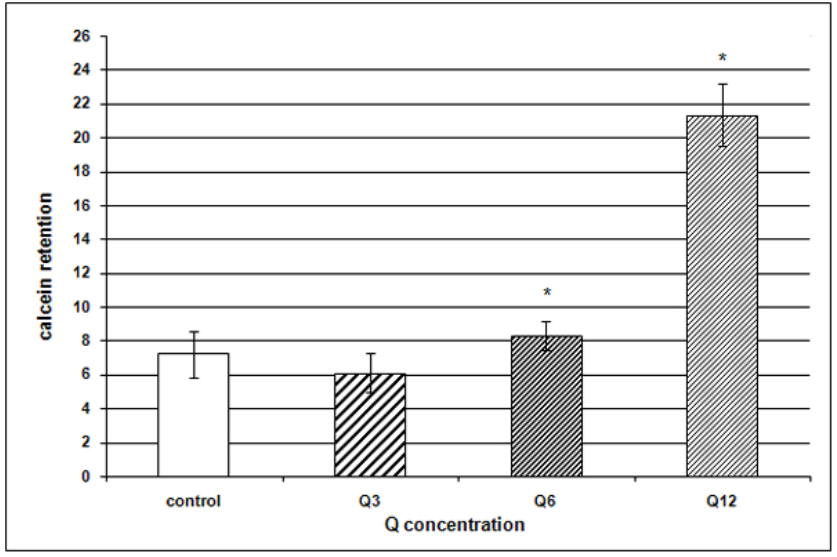
Figure 4. Retention of calcein in cells of EPP85-181RDB line following administration of various Q concentrations, as compared to the control; * p < 0.001 as compared to control.